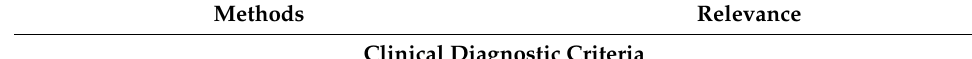
Table 1. Innovation in Diagnosis of